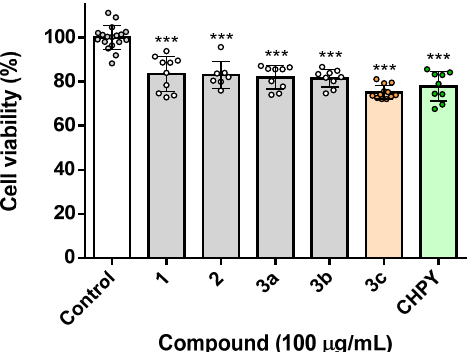
Figure 1. Viability of Sf9 insect cells exposed to the molecules under study 3a–c (100 µg/mL), or medium (control), or the reference insecticide chlorpyrifos (CHPY). *** p < 0.001.